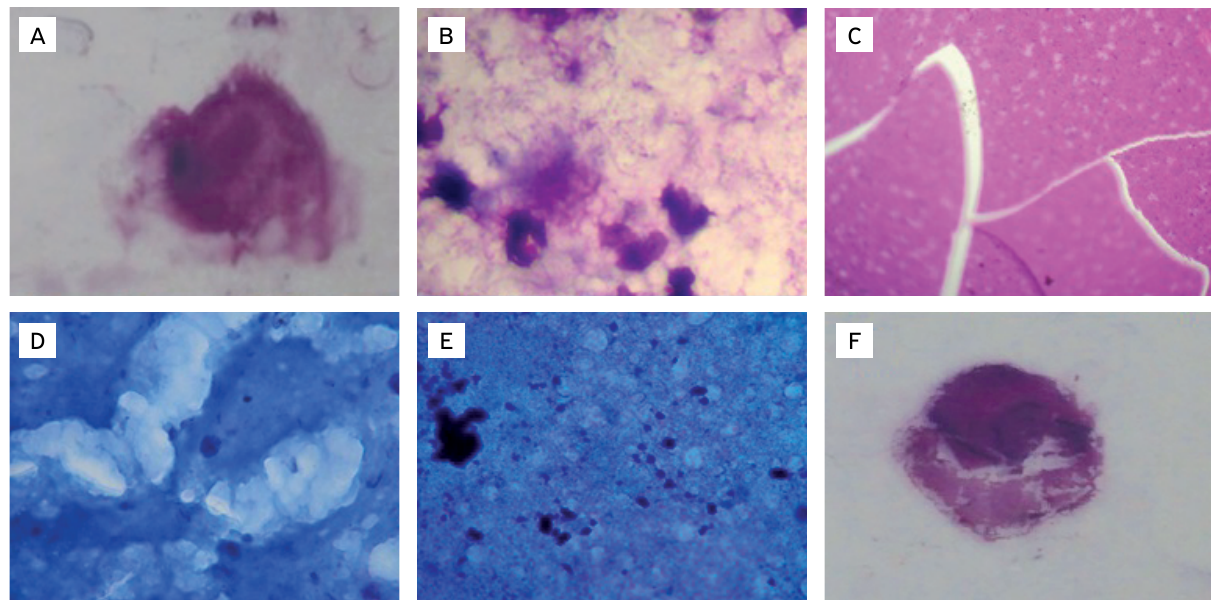
A: Blurred slide; B: dirty field (magnification 100 ×, immersion in oil); C: crackled (magnification 100 ×, immersion in oil); D: little stained (magnification 100 ×, immersion in oil); E: very stained (magnification 100 ×, immersion in oil); F: milk film without fixation. Figure 1. Organization of groups of slides for somatic cell counts in ewes’ milk, according to the presented characteristics.